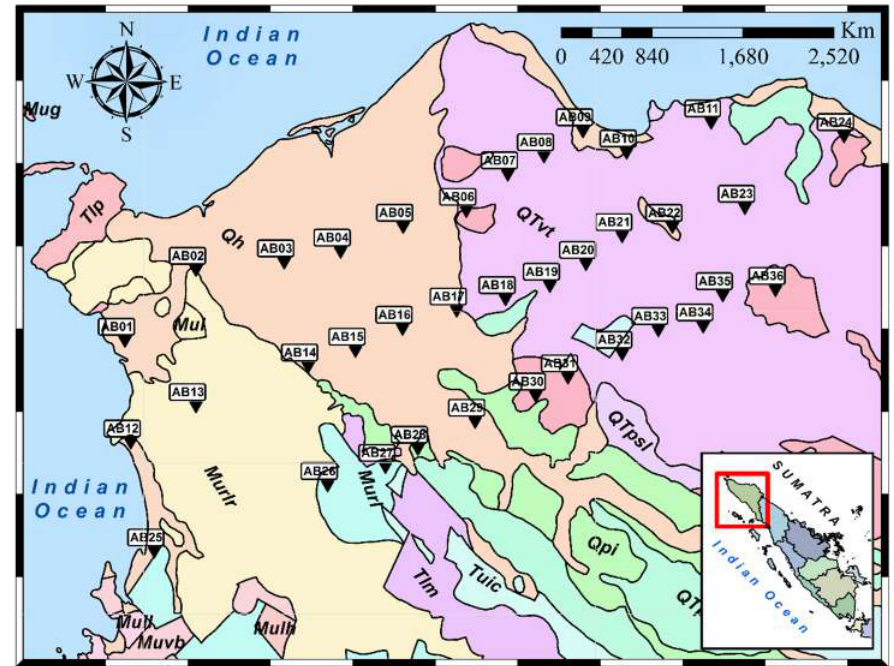
Fig. 2: Geological map of Banda Aceh and Aceh Besar regency (modified Barber et al., 1998). Most materials around the study area are composed of young alluvium (Qh), volcanic rocks (QTvt) and limestone (Murl) from the Cenozoic until the Tertiary. Measurement points are at 36 locations around Banda Aceh and Aceh Besar cross the Sumatran and Seulimeum faults, with the distance between each site being 5–10 km